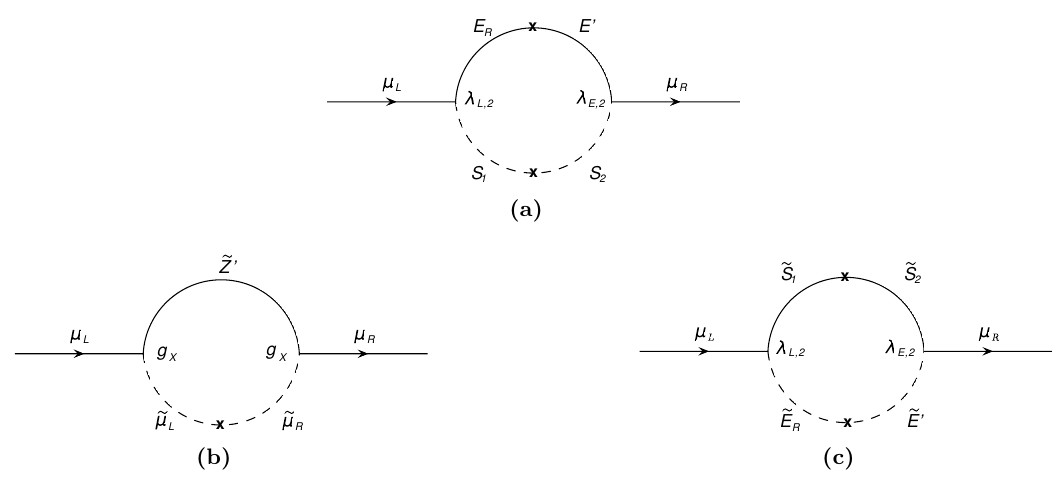
Figure 2. (a) The contribution to ( g (cid:0) 2) (cid:22) from the singlet scalars and VL lepton (cid:12)elds. (b), (c) Examples of contributions from neutralino/slepton loops that cannot be found in the MSSM. In all cases it is implied the photon line is attached to the electrically charged particle in the